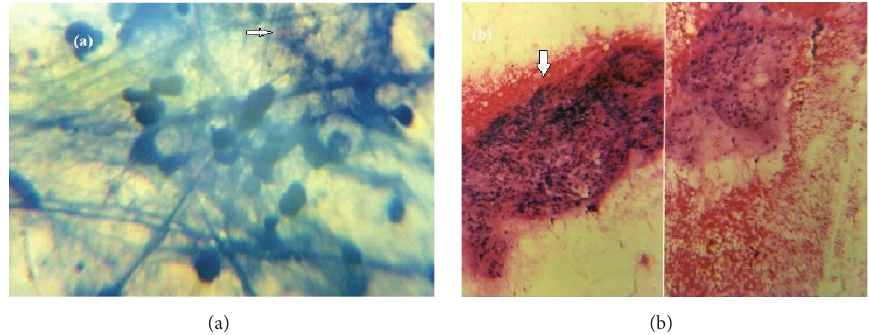
Figure 2: (a) Immunofluorescence using AFB (ICC, ∗ 100 x) confirms that the antibody specifically stains one or a few mycobacteria (white arrow) inside the cytoplasm of cells. (b) On histopathological analysis (H and E, ∗ 100 x) there was collection of ill-defined epithelioid cells, lymphoid cells, and multinucleate giant cells with central area of necrosis within (white